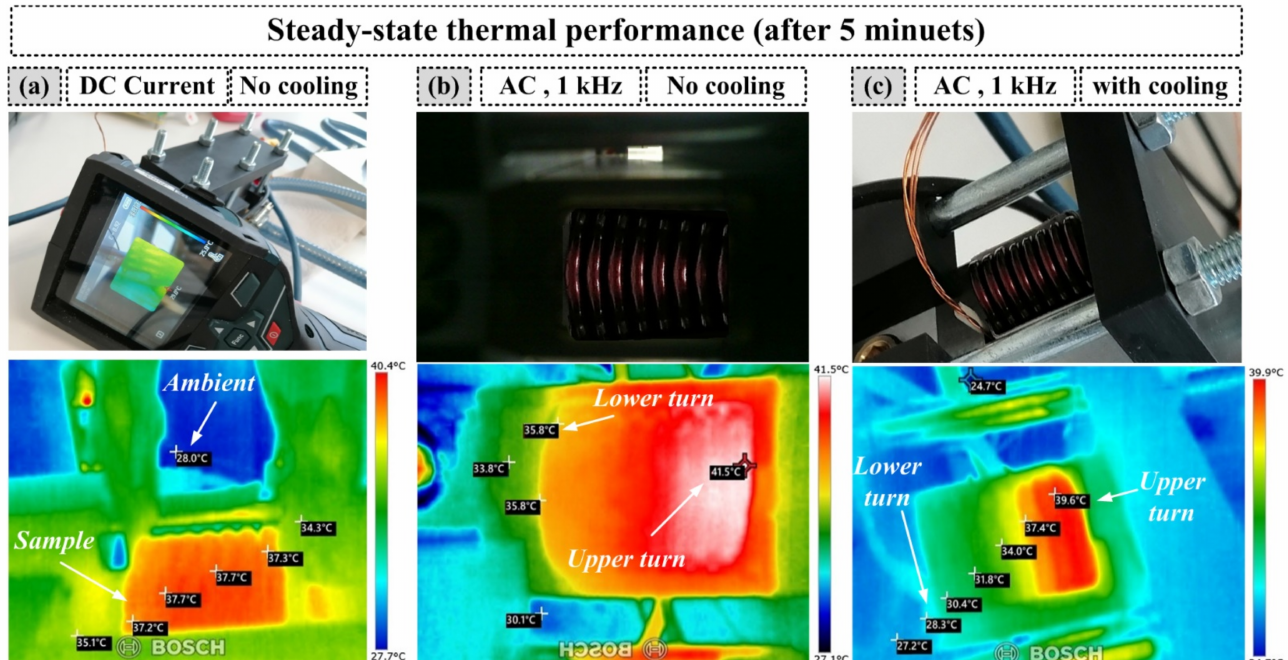
Figure 10. Thermal behavior of the test samples under steady-state currents: ( a ) DC excitation without cooling—uniform temperature; ( b ) AC excitation without cooling—nonuniform temperature; ( c ) AC excitation with forced cooling—nonuniform